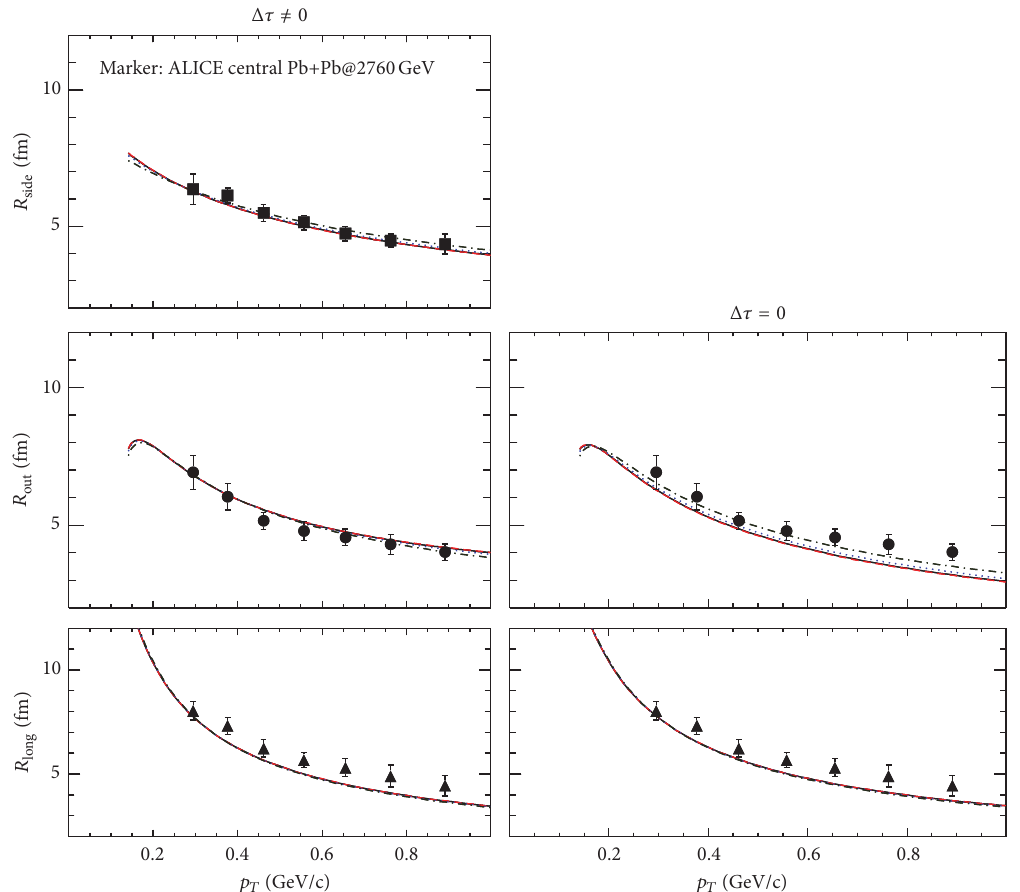
= 2760 GeV. Markers are experimental data from NN